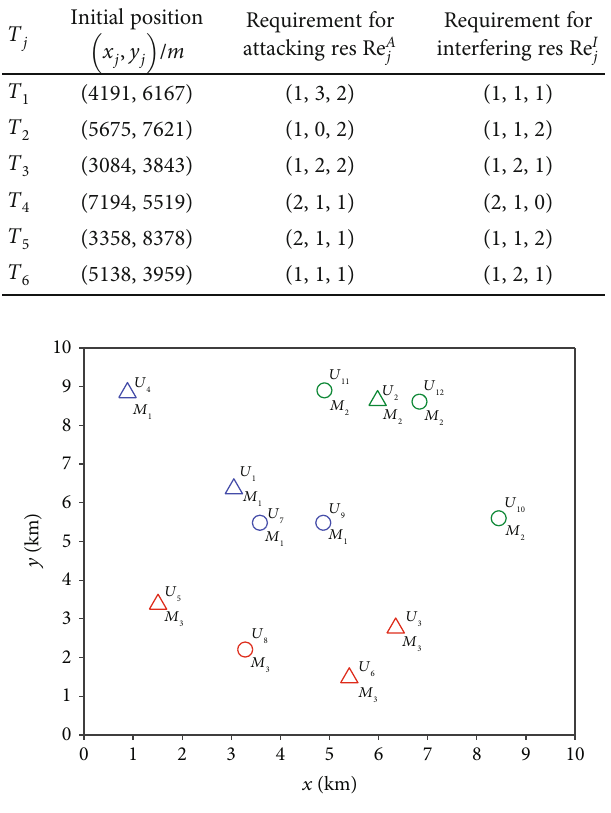
Figure 4: The clustering result obtained by normal cluster.